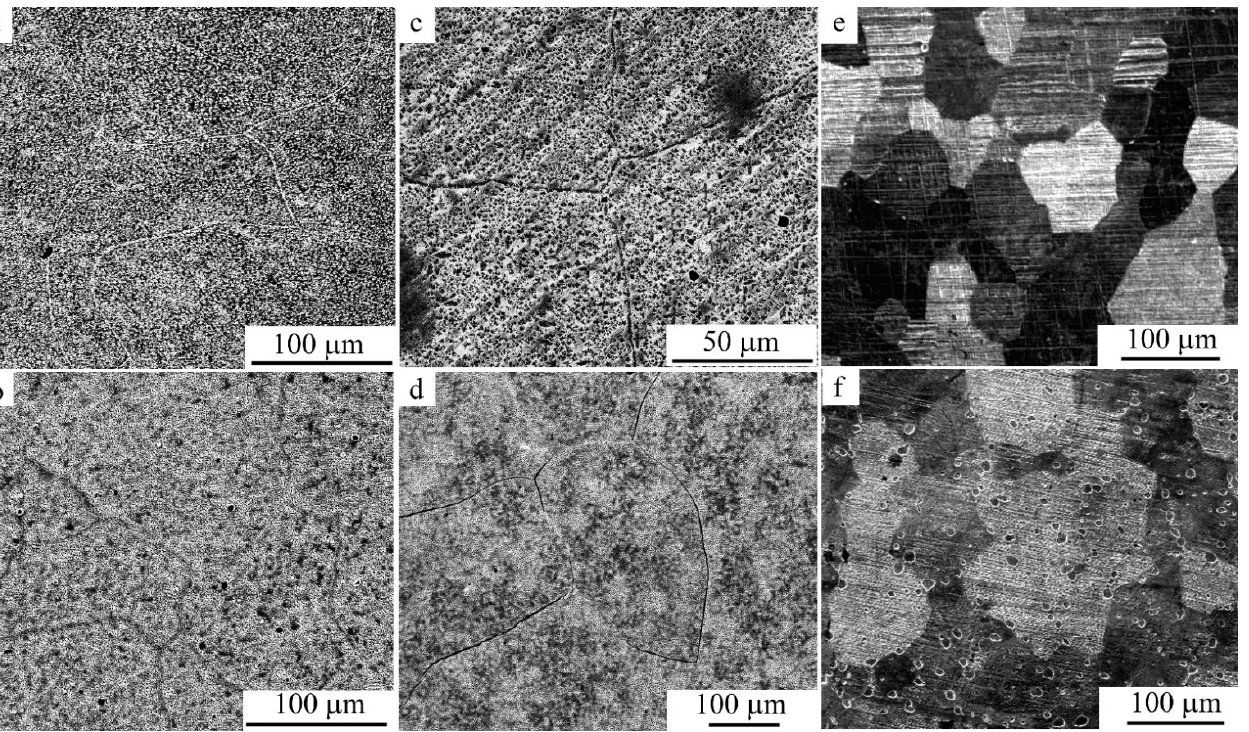
Figure 21. X-ray diffraction patterns for the Cu–14Al–4Ni alloy taken after MPC with rate 1 (mm/min) at ( a ) 673 and ( b ) 873 K.